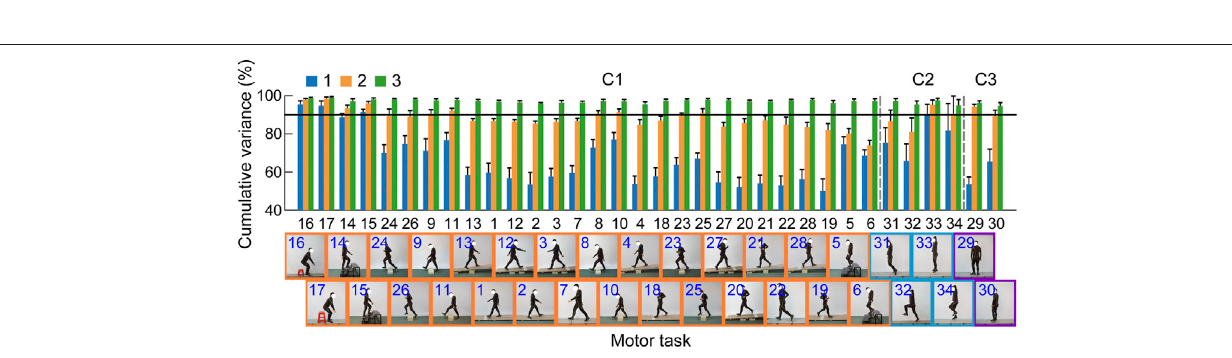
FIGURE 5 | Movement reconstruction of each task by the combination of the core synergies in the clusters (C1 – C3). The bar graph depicts the percentage of the total joint motion variance of each task (means and standard deviations across the subjects, n (cid:1) 9) explained by the fi rst (blue), the fi rst two (orange), and the fi rst three (green) core synergies in the three clusters. The reconstruction quality is considered good if the variance explained > 90% (black horizontal line).